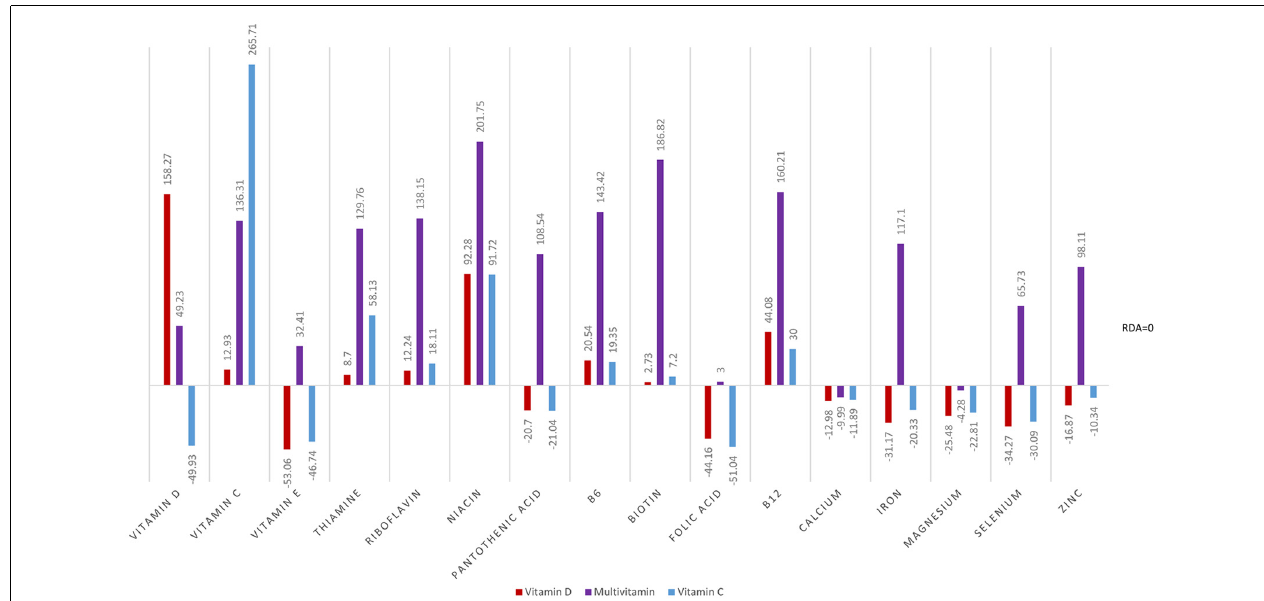
Multivitamin Vitamin D Vitamin C